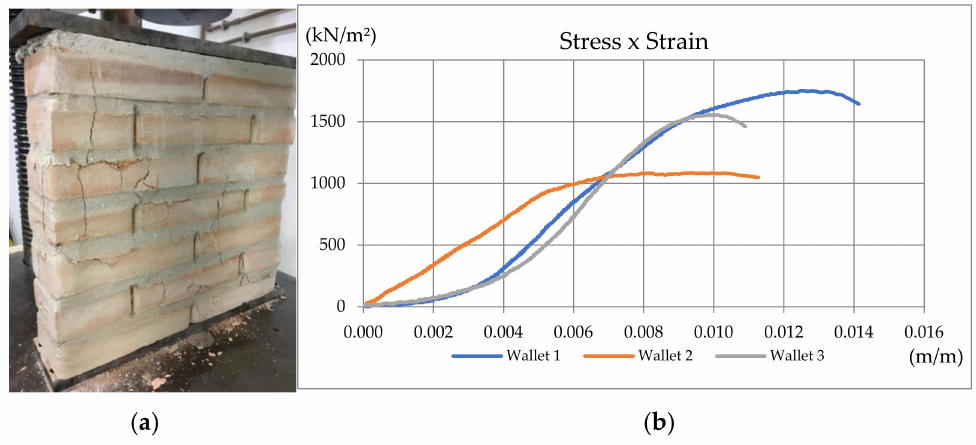
Figure 13. ( a ) Wallet Specimen 1; ( b ) Stress–strain curve for 50 cm spaced grouted wallet specimens [34].